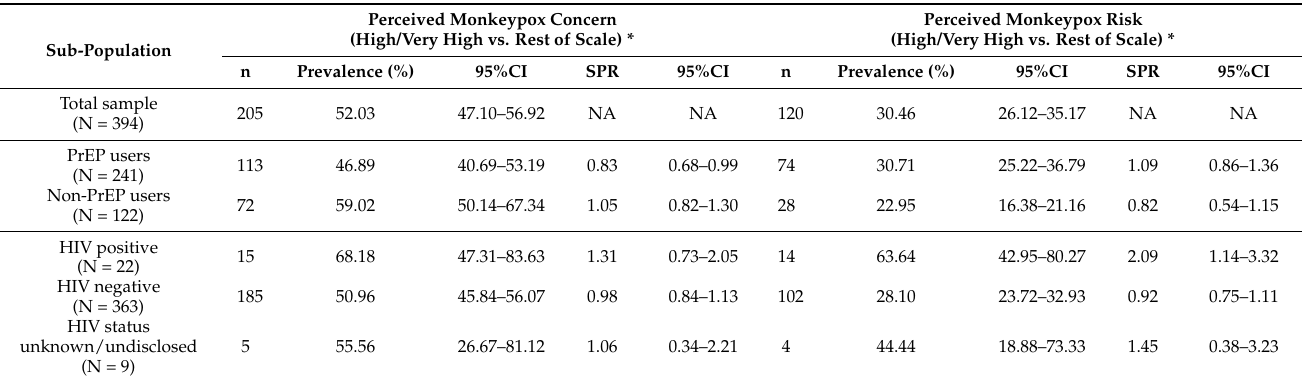
Table 2. Prevalence and standardised prevalence ratio of perceived monkeypox concern and risk among MSM in The Netherlands, July